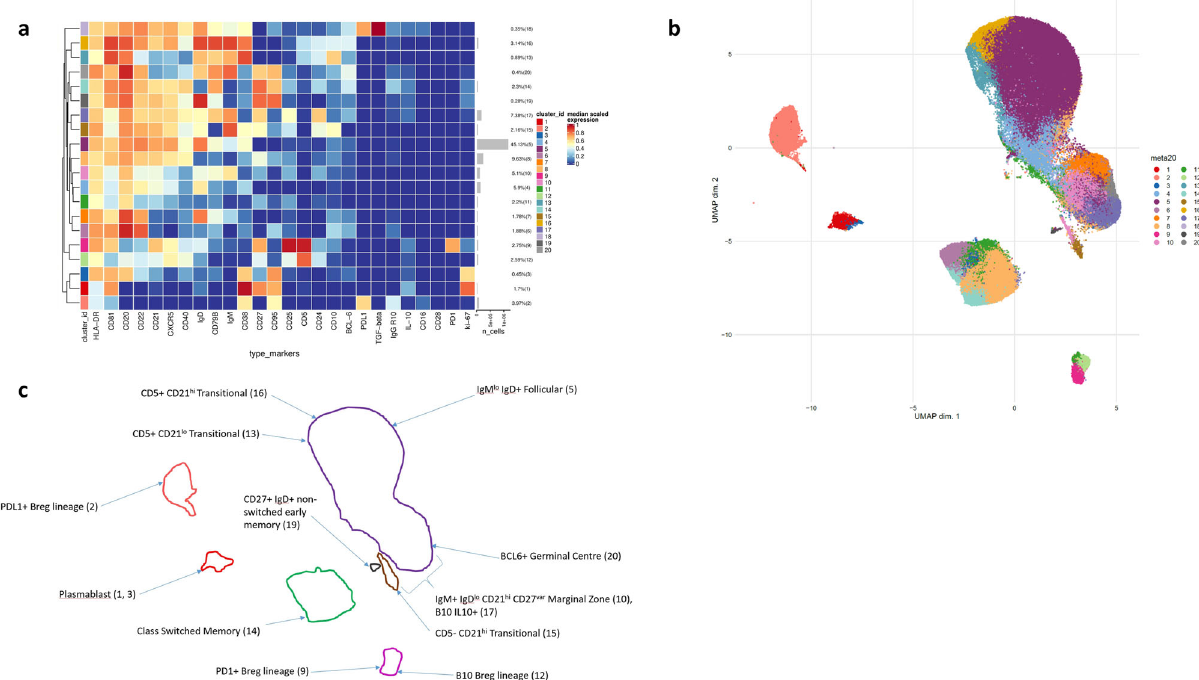
Fig. 2 Base B-cell panel phenotyping in NSCLC cohort ( n = 46). a Heatmap showing normalised expression of the base B-cell panel markers for the 20 B-cell clusters identi fi ed with FlowSOM. The cluster IDs and relative frequencies are displayed as a bar graph on the right-hand side, along with the median scaled expression. b UMAP plot displaying all cells from each FlowSOM-derived cluster identi fi ed in ( a ) coloured by cluster. c Schematic outline of UMAP identifying the main B-cell population as islands on the two-dimensional UMAP plot. Spatial differences between islands re fl ect the phenotypic differences between the identi fi ed B-cell populations. Similar populations aggregate